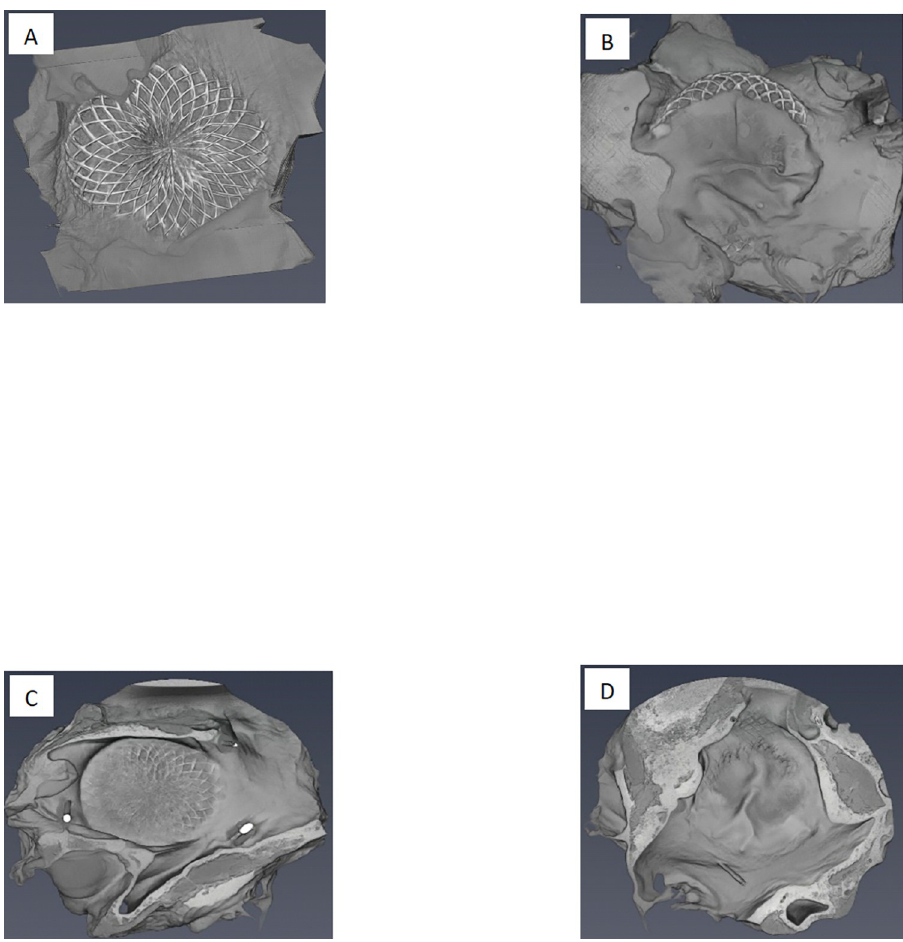
Fig 5. 3D rendered image after background-removed 3D reconstruction of the disks of two devices (devices 5 and 8), both explanted at 3 months. (A) Right-sided disk of device n˚5. (B) Left-sided disk of device n˚5. (C) Right-sided disk of device n˚8. (D) Left-sided disk of device